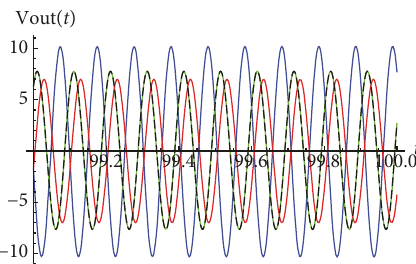
Figure 25: 𝑉 𝑜𝑢𝑡 (𝑡) at asymptotic state of Type A Wien oscillator: fractional memristor with 𝛼 = 0.75 (blue), fractional memristor with 𝛼 = 1 (green), fractional memristor with 𝛼 = 1.25 (red), and HP memristor (black dots).